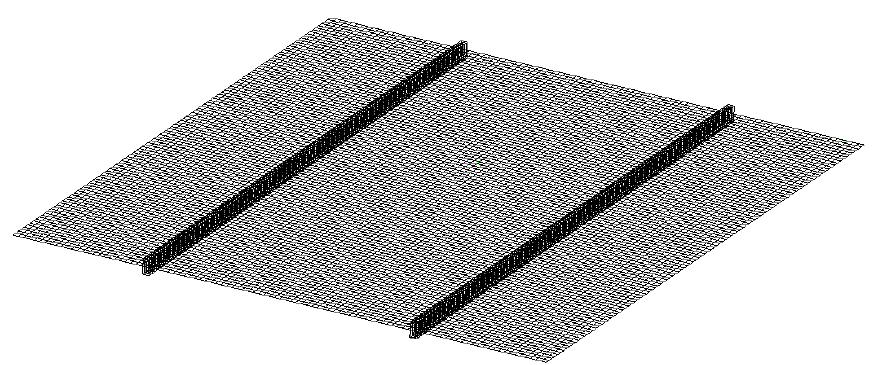
Figure 11. The arrangement of the stiffener.